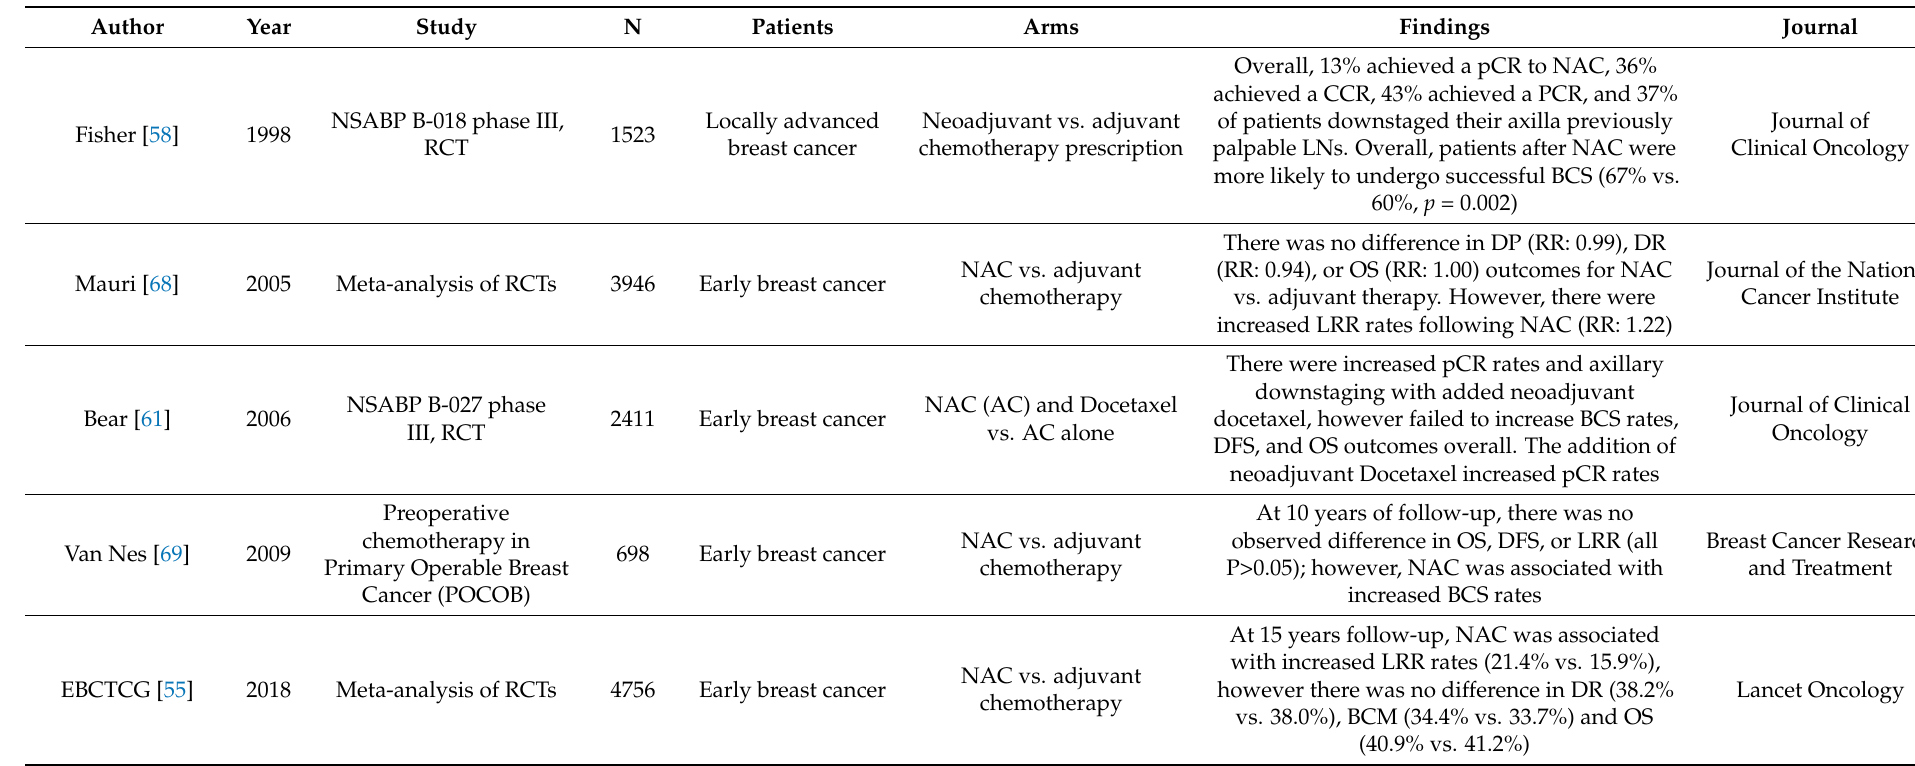
Table 2. The outline of seminal studies validating neoadjuvant chemotherapy prescription in breast cancer